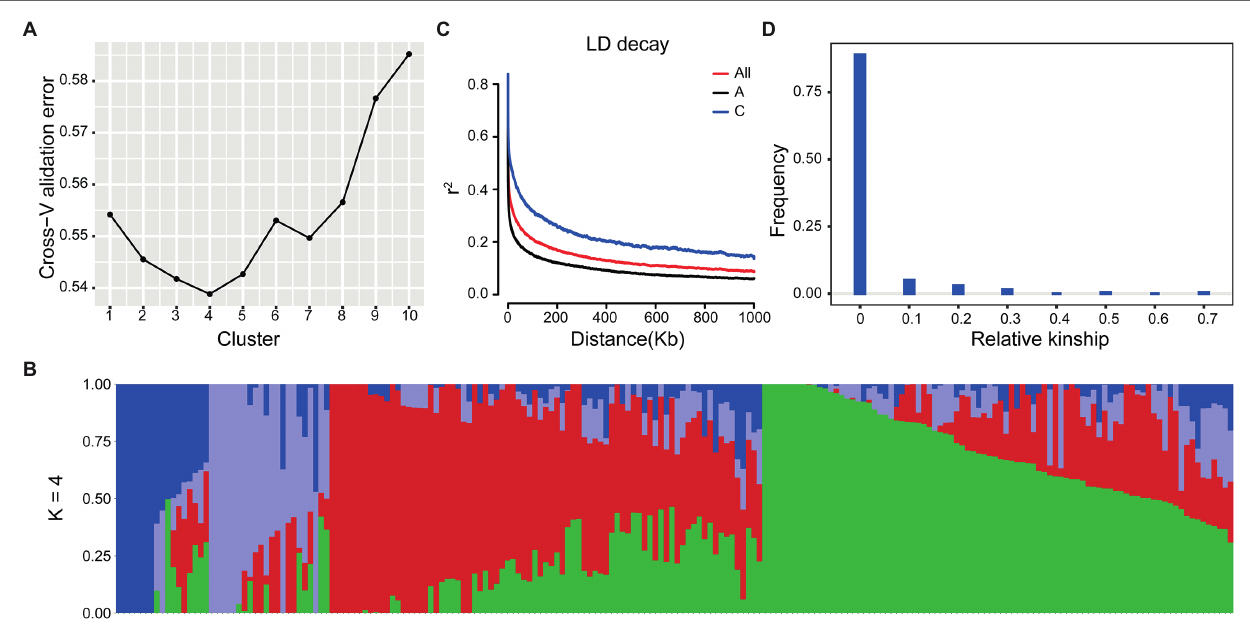
FIGURE 2 | Population structure of Brassica napus accessions. (A) The value of cross − validation error in different K value. (B) Model-based group analysis in K = 4. The y axis quantifies clusters membership, and the x axis lists the different B. napus accessions. (C) Genome-wide and sub-genome average LD decay estimated. (D) Relative kinship of 204 B. napus accessions.